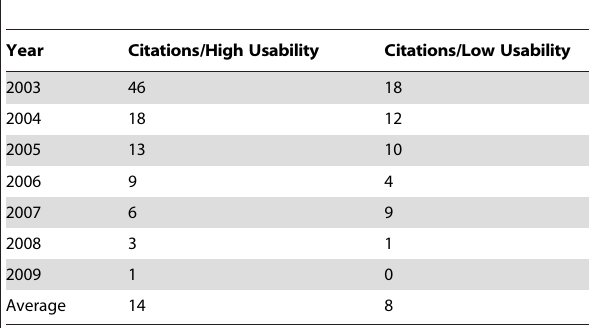
Table 5. Average Citations for Services with High and Low Usability from 2003 to